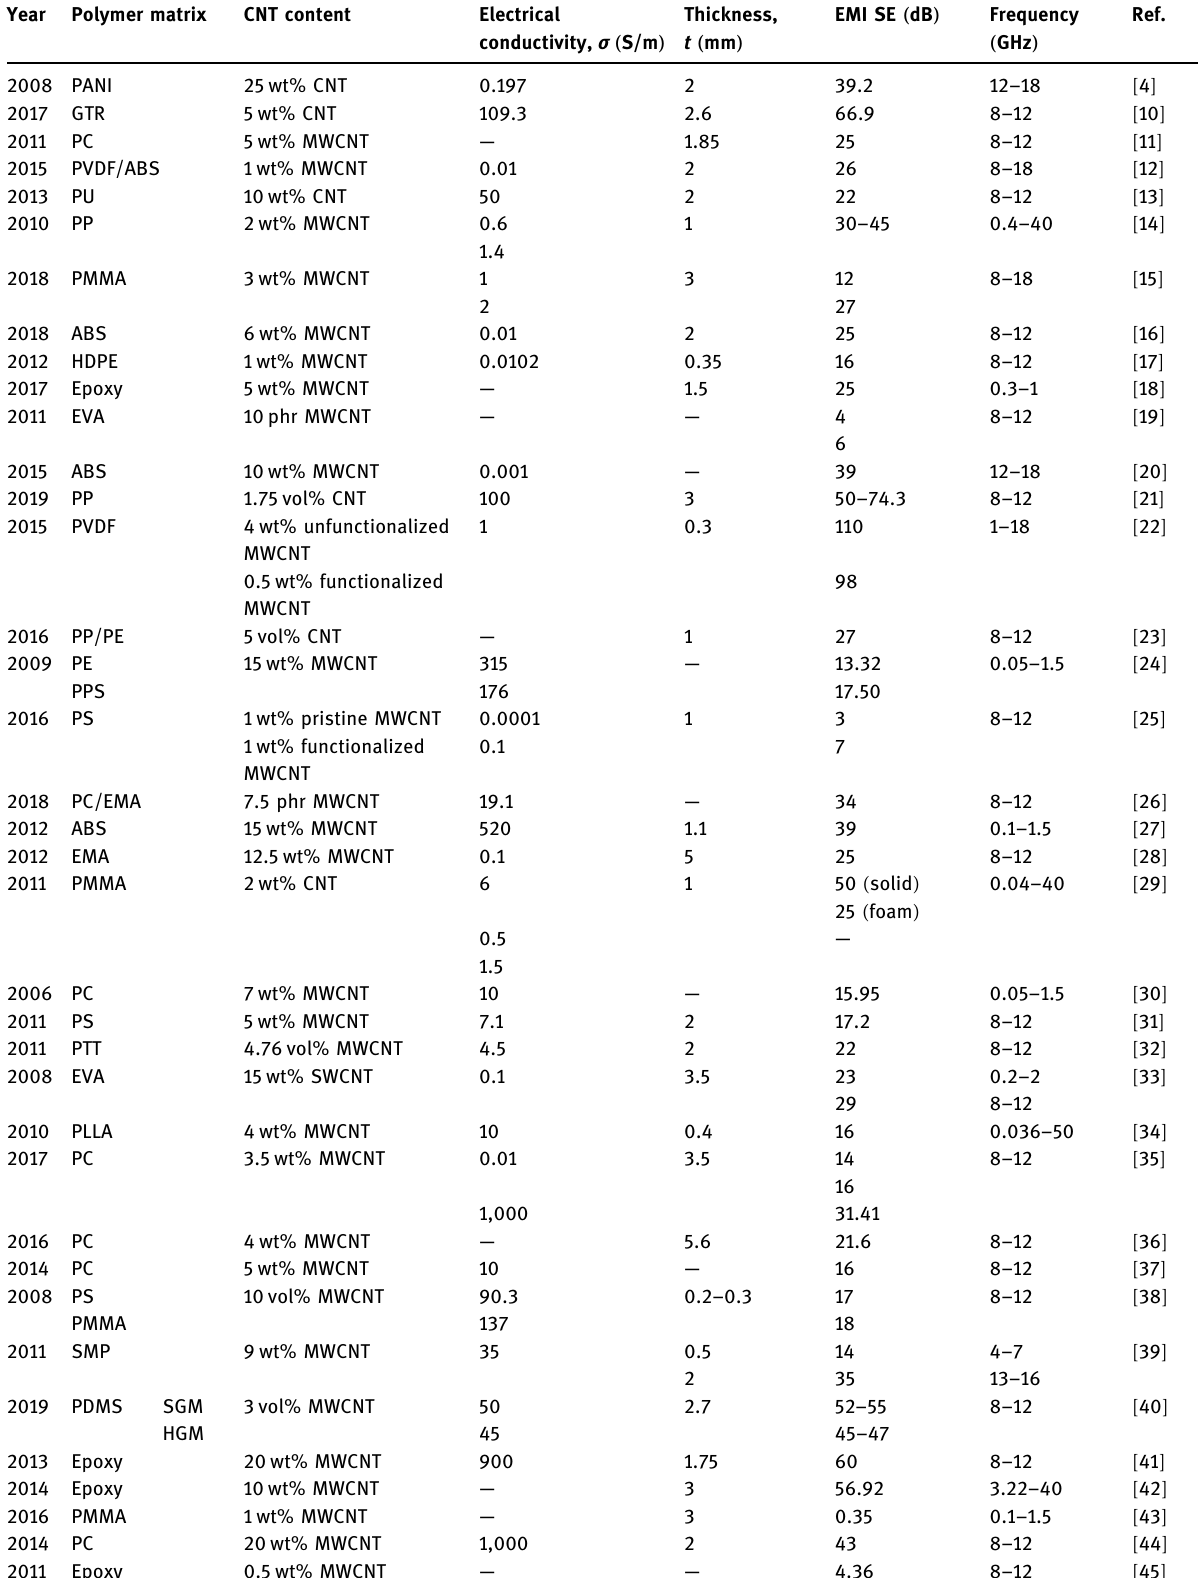
Table 1: Electromagnetic shielding of CNT